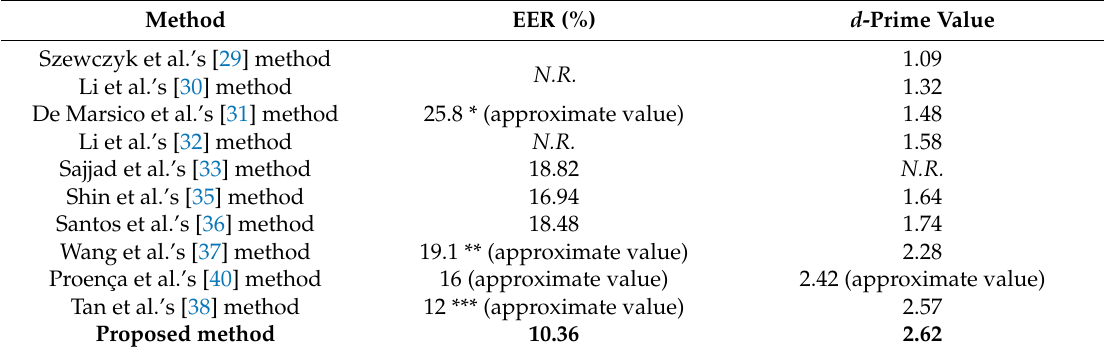
Table 6. Comparison between the recognition method suggested by this study and methods of other preceding studies ( N.R. means, “not reported”).